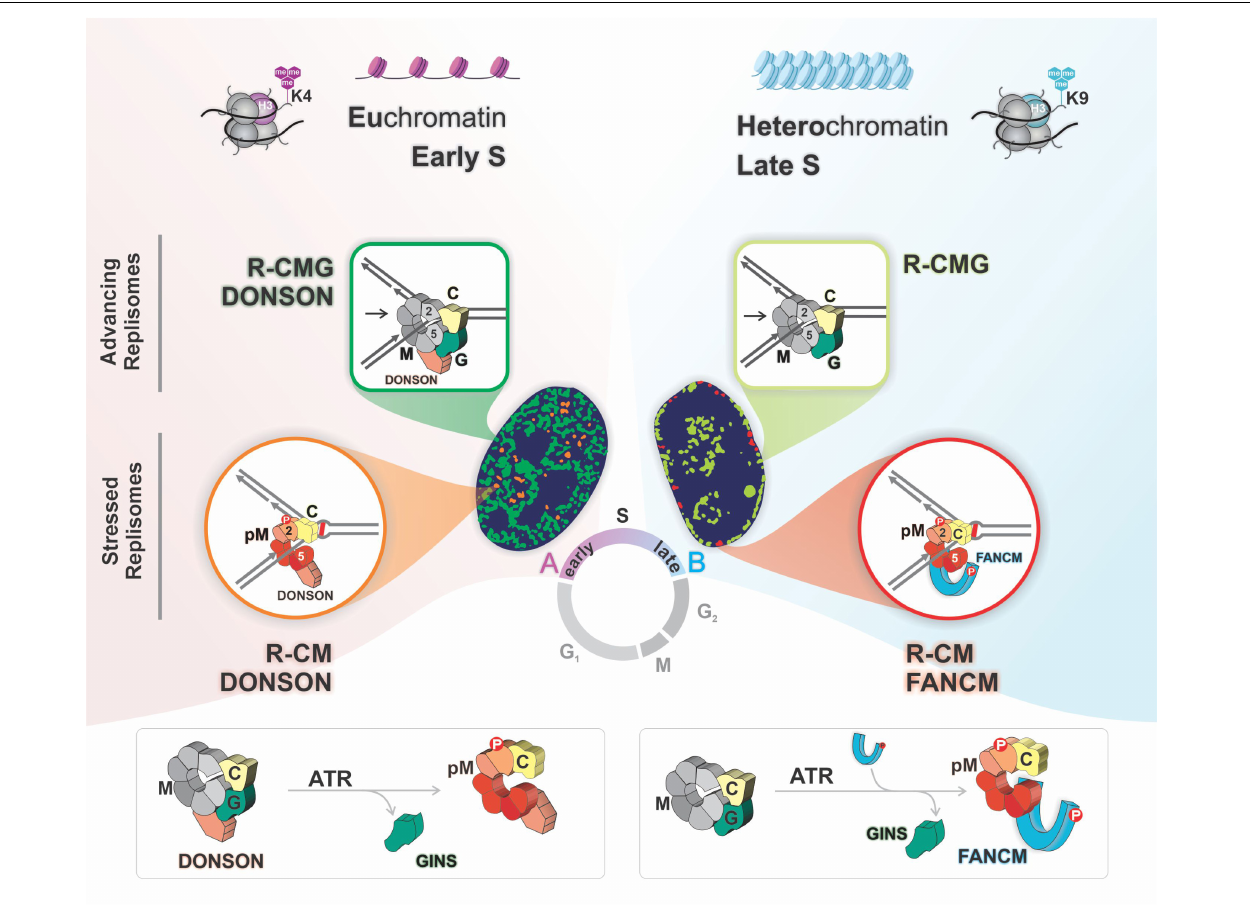
FIGURE 2 | Replisomes with alternative compositions are active in the two chromatin compartments. There are two advancing replisomes, one with DONSON (R-CMG DONSON), biased toward early replicating euchromatin, and one without (R-CMG), preferentially localized to late replicating heterochromatin. In euchromatin the encounter with an ICL triggers MCM2 phosphorylation on serine 108 by ATR, and eviction of the GINS proteins yielding R-CM DONSON. In heterochromatin there is an ATR dependent recruitment of FANCM which is required for the loss of the GINS and the formation of R-CM FANCM.